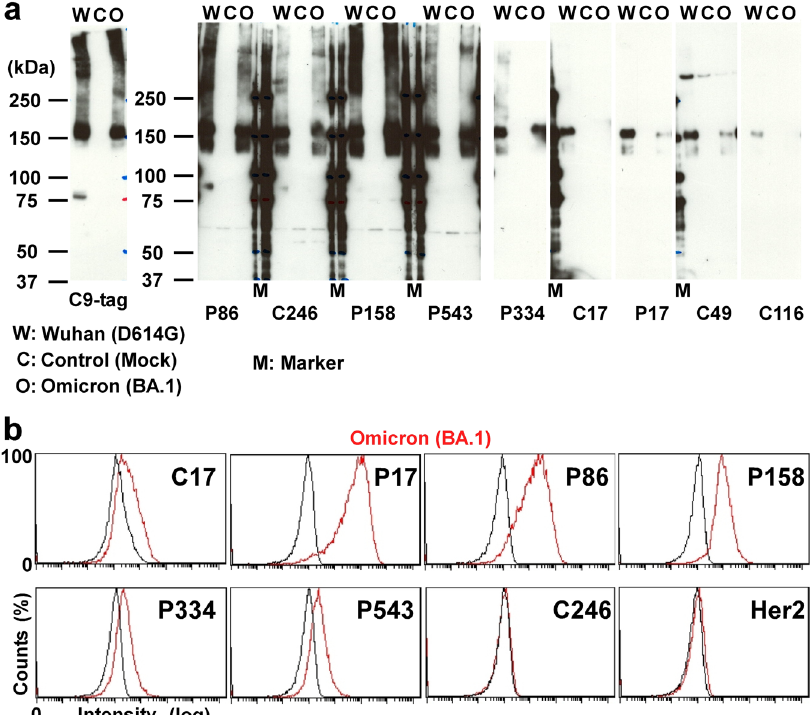
Fig. 3 Nanobodies against the SARS-CoV-2 Omicron variant. a Nanobody-based western blotting assays of SARS-CoV-2 spikes. HEK293T cell lysates (C: as control of mock transfection) expressing the C-terminally C9-tagged SARS-CoV-2 spike proteins (W: Wuhan-1) and one of the Omicron variant (O: Omicron BA.1) were blotted with an anti-C9 antibody and the indicated nanobodies. b Flow cytometric analyses of DT40 cells. Log scaled signals (x-axis) of the indicated eight nanobodies with parent cells (black) and cells stably expressing the SARS-CoV-2 Omicron spike protein (red) were counted (y-axis) and